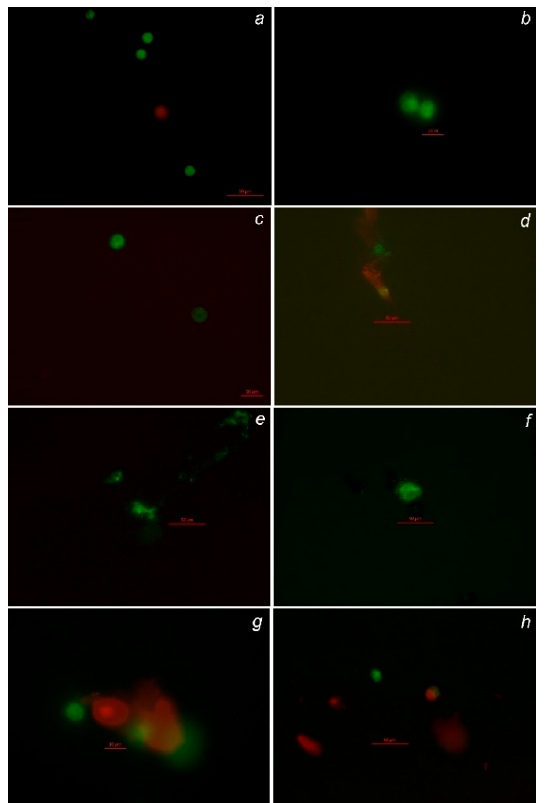
Figure A2. The hemocyte cells of the mollusc M.modiolus after 6 h of exposure with the NPs at the concentration of 1000 mg / L: ( a ) control; ( b ) CNT-1; ( c ) CNT-2; ( d ) SNT-1; ( e ) CdS; ( f ) ZnS; ( g ) Au-NPs; and ( h ) TiO 2